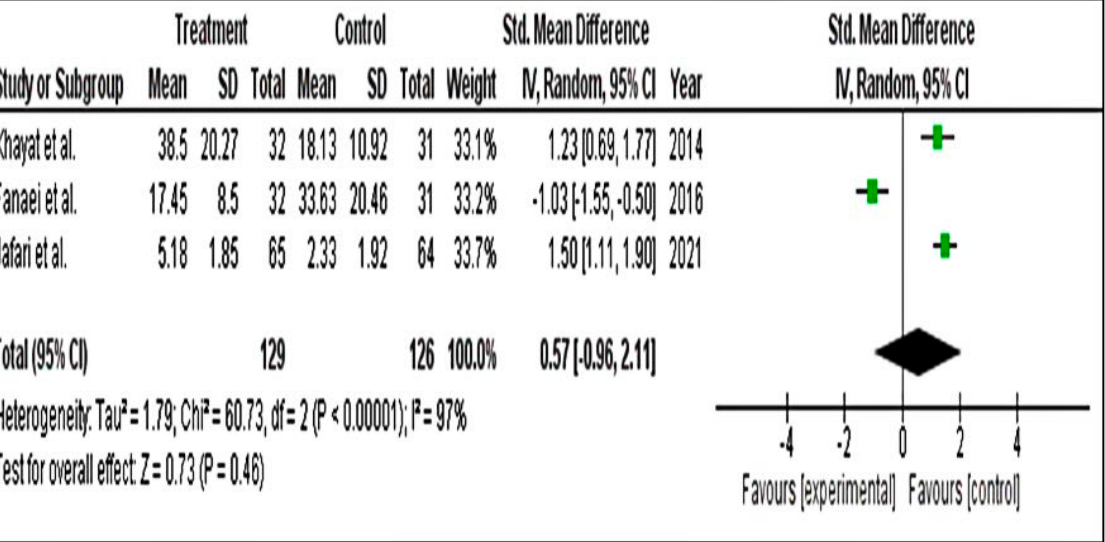
Figure 10. Forest plot for subgroup mood symptoms of PSST scale [5,45,51].